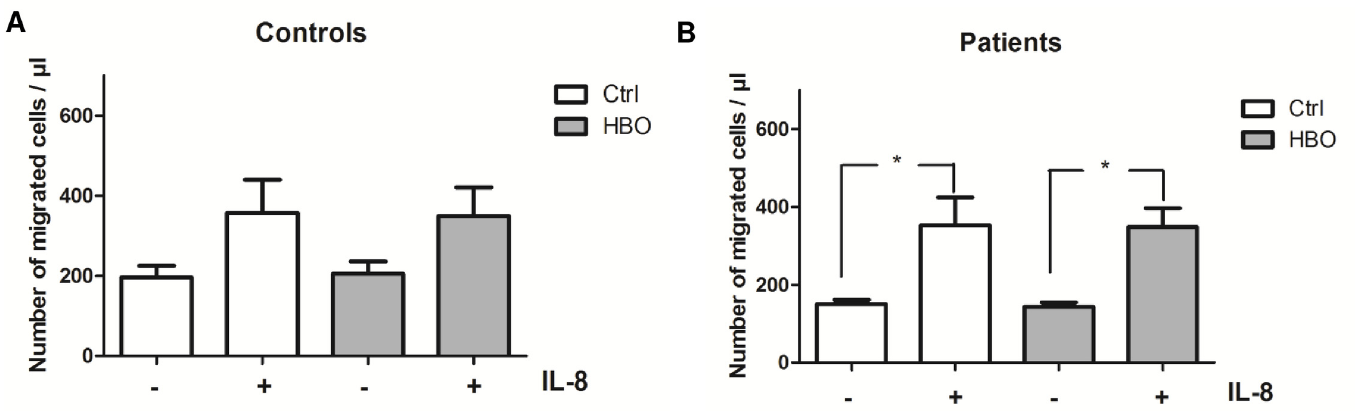
Fig 3. Effect of HBO on neutrophil chemotactic activity. After HBO (2.0 atm; 120 min), neutrophils from polytraumatized patients (Patients; n = 4) and volunteers (Controls; n = 6) were transferred into transwell inserts (3.0 μ m pore size) and spontaneous as well as migration in response to IL-8 (25 ng/ml) were determined after 30 min of incubation under cell culture conditions. Cells incubated under normoxic and normobaric conditions served as controls. * p < 0.05